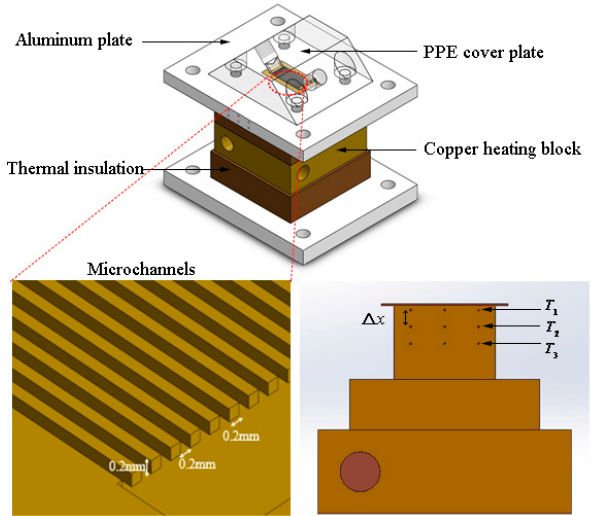
Figure 2. Test section schematic.